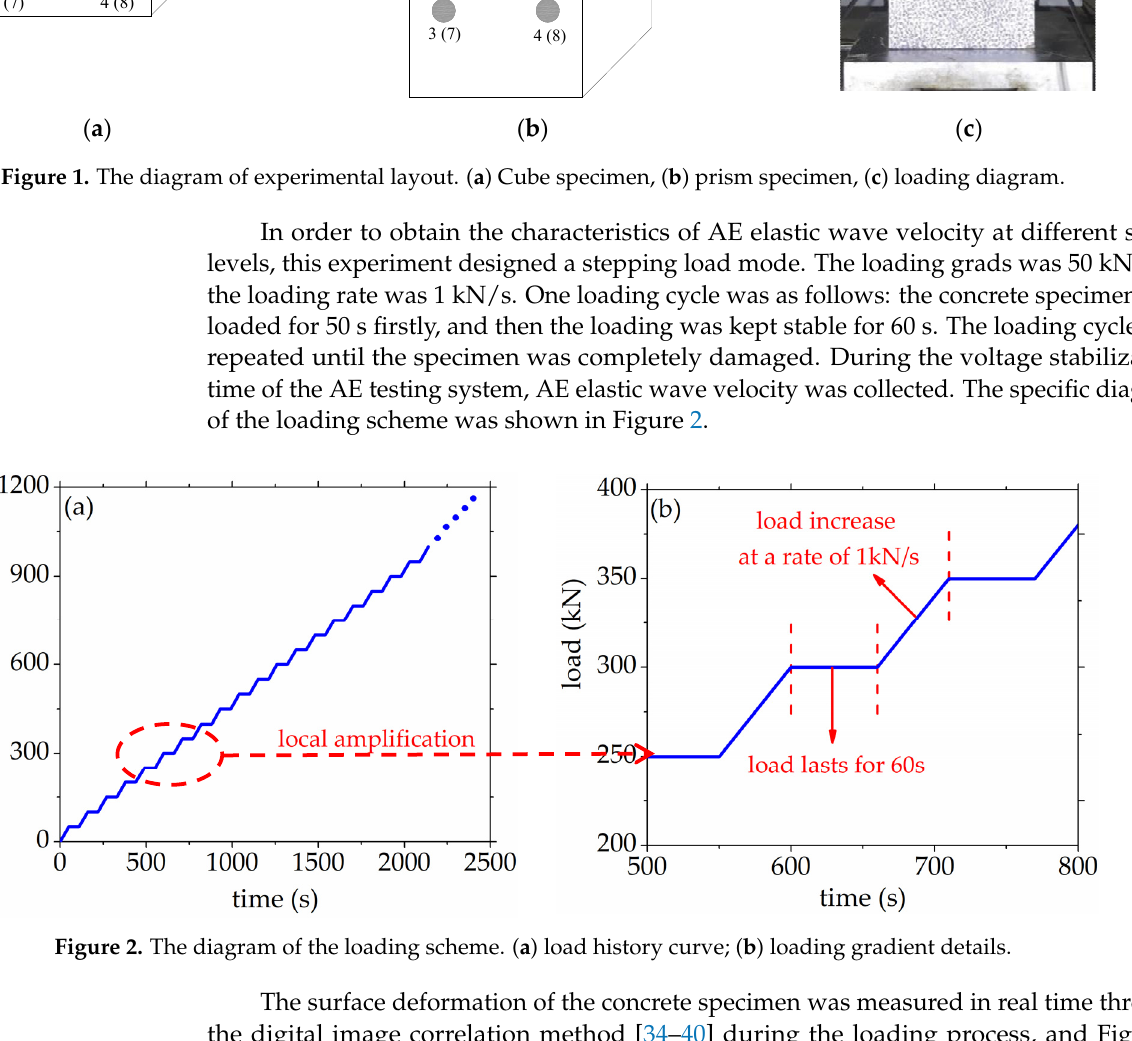
Figure 2. The diagram of the loading scheme. ( a ) load history curve; ( b ) loading gradient details. The surface deformation of the concrete specimen was measured in real time through the digital image correlation method [34–40] during the loading process, and Figure 3 showed the strain collection system. The instrument is the Vic-3D non-contact full-field strain test system produced by American Correlated Solutions. The speckles were artifi- cially dotted on the surface of the concrete specimen, and the deformation of the speckles were tracked by a high-speed camera which has 5 million pixels. The displacement accuracy is 0.01 pixels, sampling rate is 20 Hz, and the picture quality is 1920 × 2448